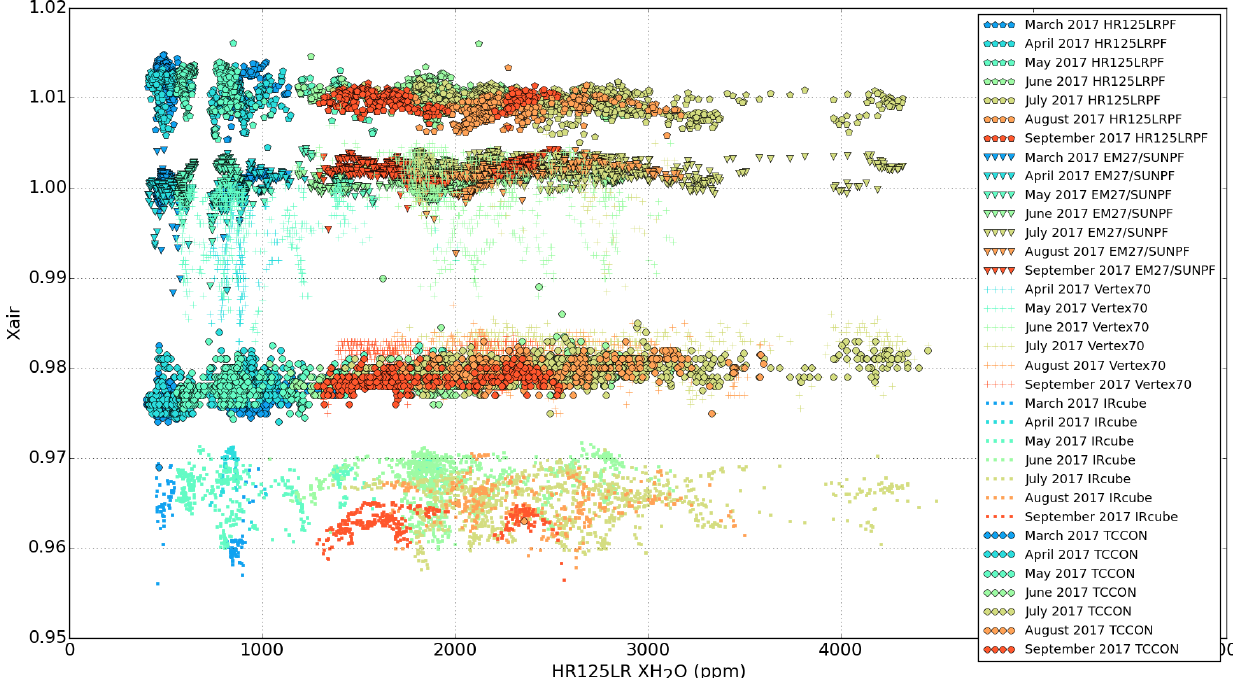
Figure F3. Xair plotted for HR125LR, EM27/SUN, Vertex70, IRcube, and TCCON with respect to the total column water vapour retrieved by the reference HR125LR measurements. The colours represent the measurement performed during the different months of the